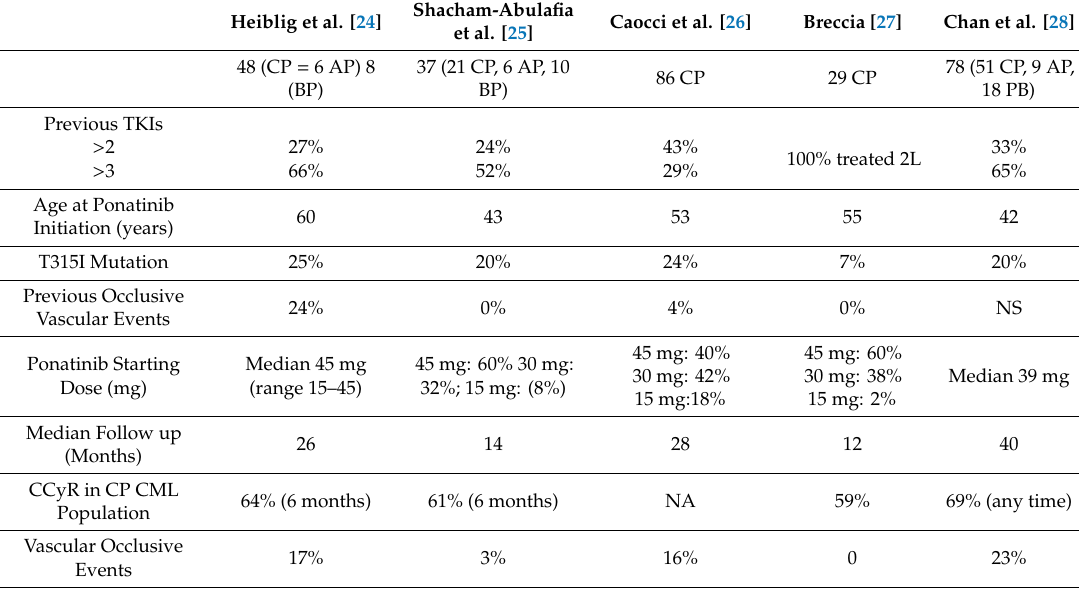
Table 2. Ponatinib studies in clinical